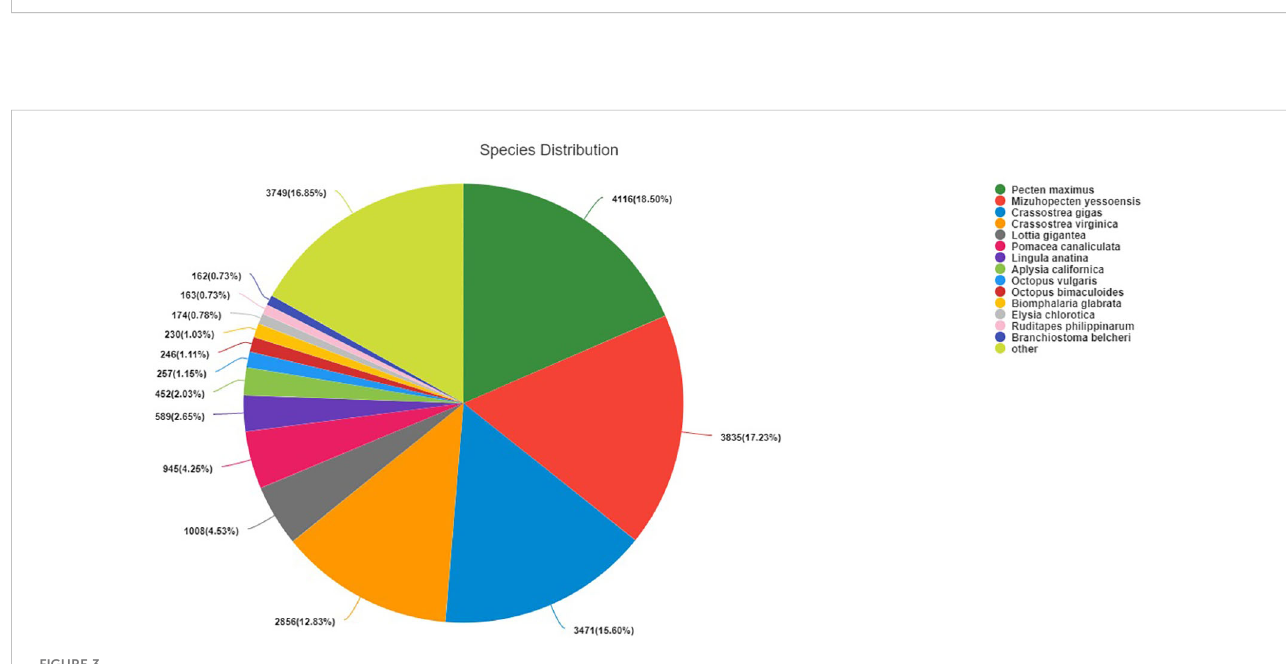
FIGURE 3 Species distribution of BLASTx hits.